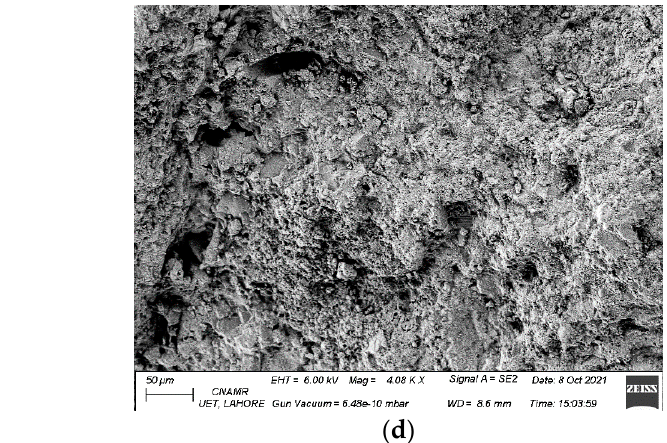
Figure 9. SEM images of specimens with varying percentages of MS ( a ) control specimen (50 μ m) ( b ) 10% MS (50 μ m) ( c ) 40% MS (100 μ m) ( d ) 40% MS (50 μ m).